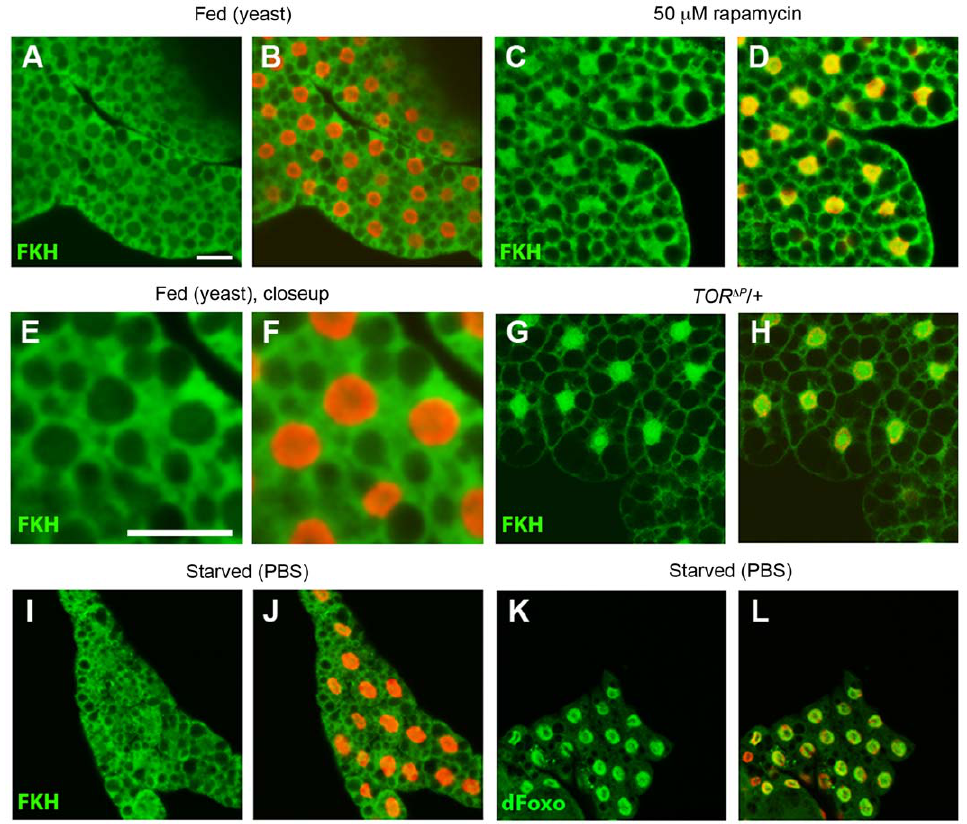
Figure 4. Subcellular localization of FKH is modulated by nutrient availability and TOR signaling. Confocal sections of larval fatbody are shown. For each section, one panel shows only the signal derived from the FKH or dFOXO antibody in green, and a second panel an additional nuclear counterstain with DAPI pseudo-colored in red. ( A , B ) FKH is excluded from the nucleus in fatbodies of wildtype 2 nd instar larvae fed on yeast. ( C , D ) FKH accumulates in the nucleus in fatbodies of wildtype larvae treated with 50 m M rapamycin. ( E , F ) Closeup of A, B. ( G , H ) FKH is nuclear in heterozygous TOR mutants ( y w; dTOR D P / + ). ( I , J ) Nuclear exclusion of FKH is not observed in larvae subjected to starvation on PBS. ( K , L ) In contrast to FKH, dFOXO shows a clear nuclear localization in wildtype larvae starved on PBS. Scale bar is 20 m